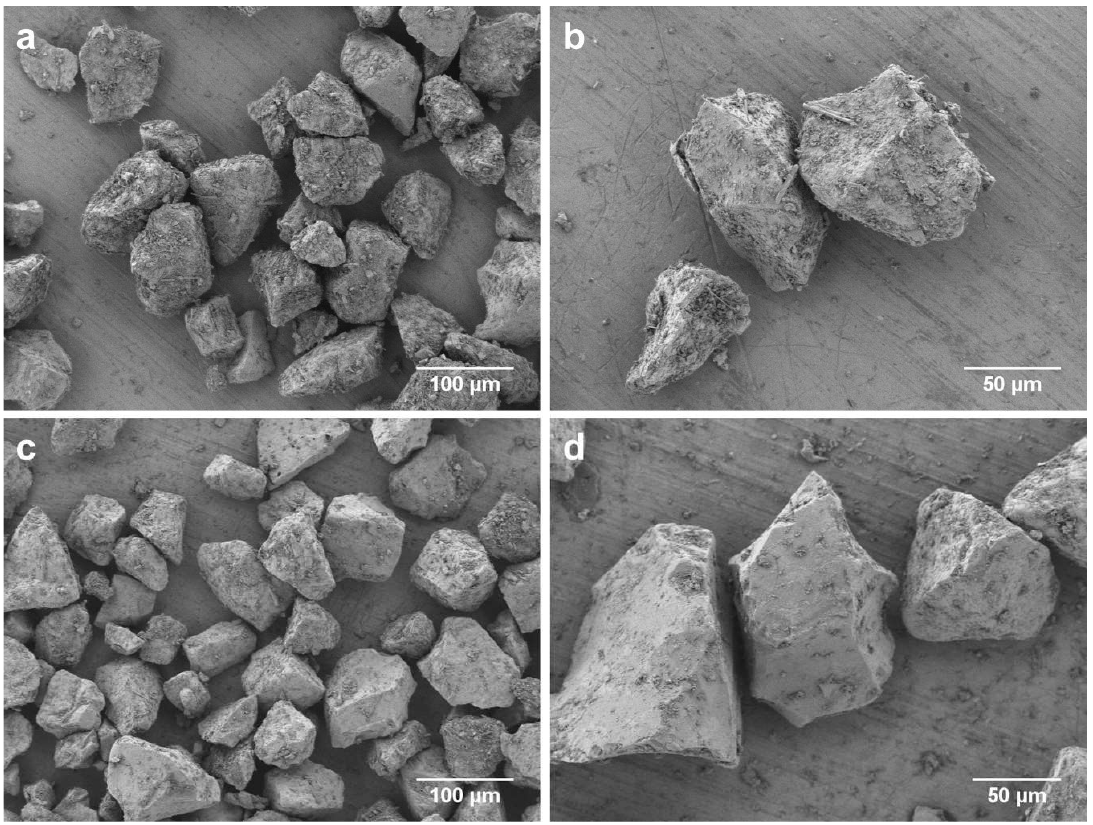
Figure 4. SEM images of the scaffold granules investigated. 45S5-CBG is depicted at a 500-fold magnification in ( a ) and at a 1000-fold magnification in ( b ), whereas ICIE16-BG is shown at a 500-fold magnification in ( c ) and at 1000-fold magnification in ( d ).